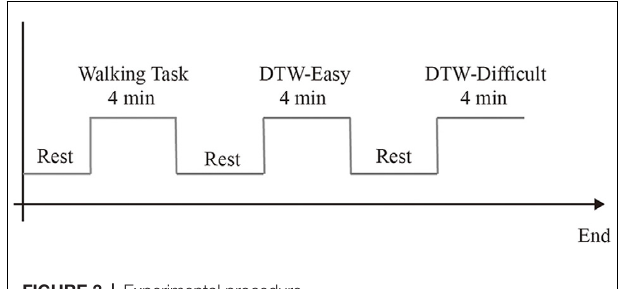
FIGURE 3 | Experimental